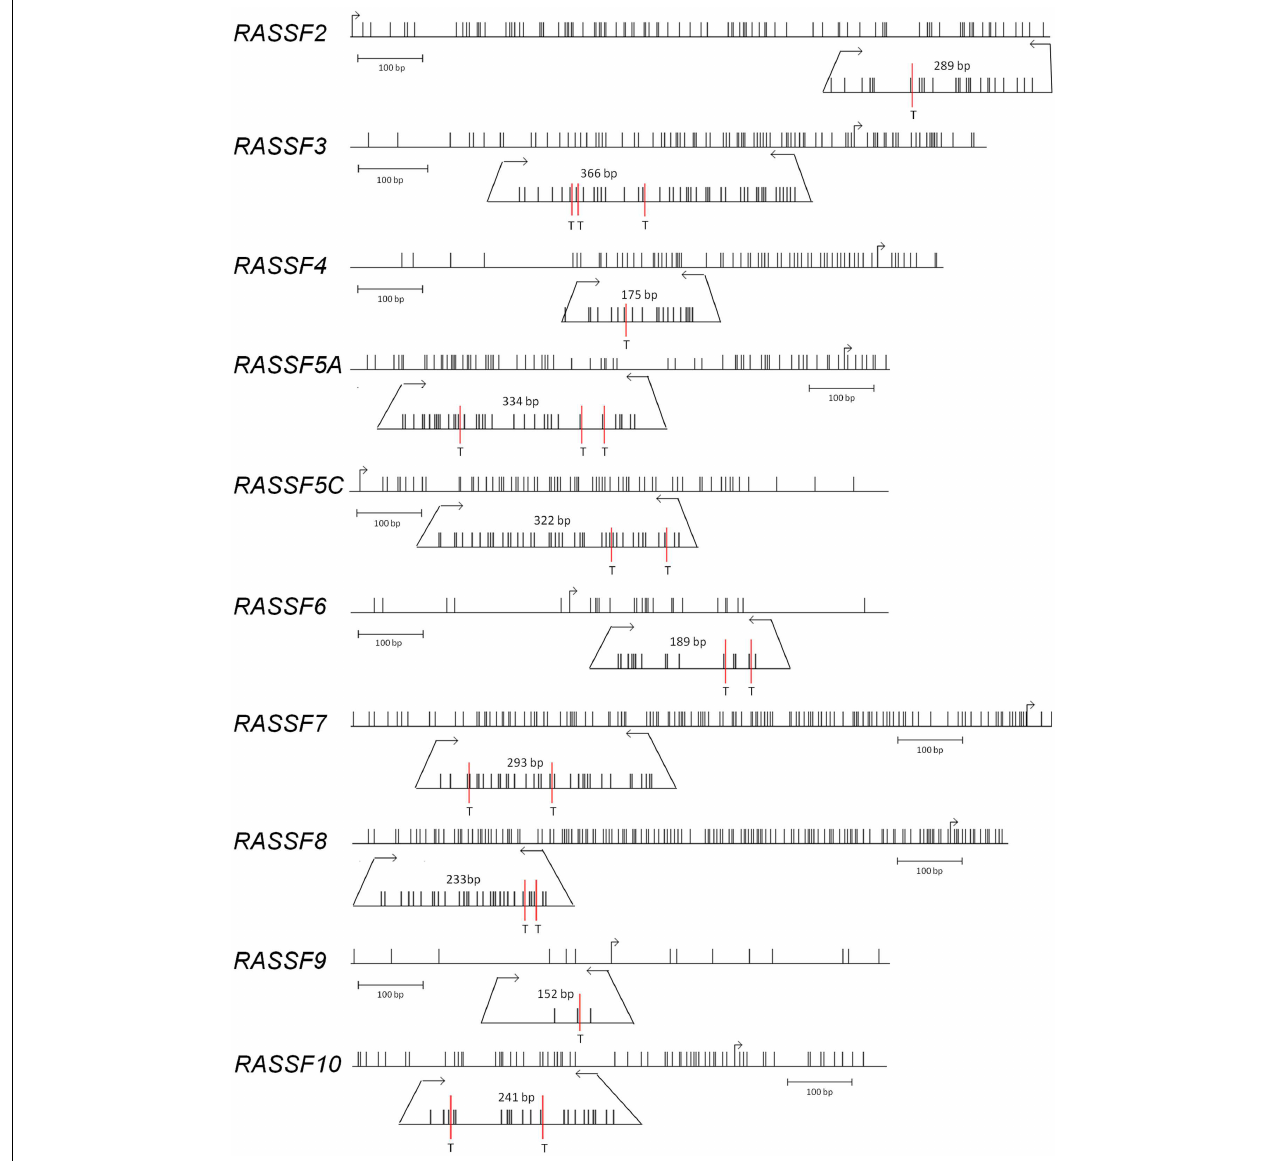
transcriptional start sites. Horizontal arrows mark the COBRA PCR products obtained after bisulfite treatment of DNA and according PCR fragment size. Hundred base pair standard is shown below each promoter region. Graphics were generated with the python.vs.cobra program